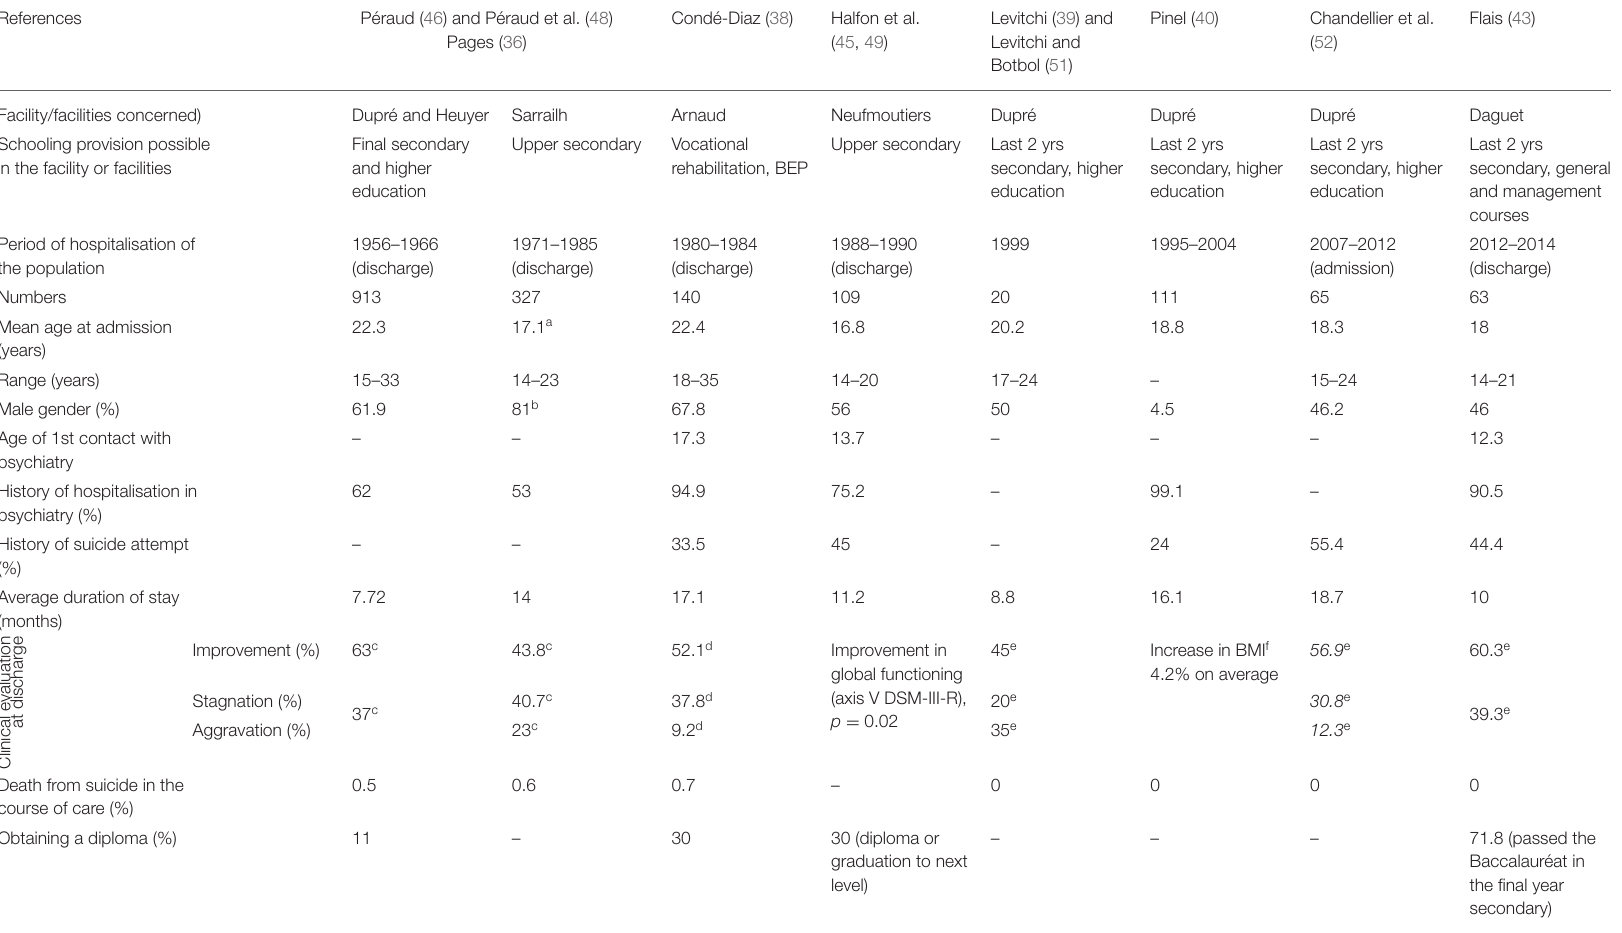
TABLE 2 | Description of the young people and their evolution in studies that assessed evolution at discharge from